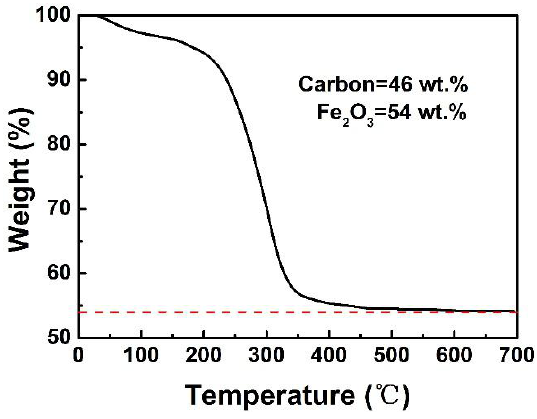
Figure 6. Thermogravimetric (TG) curve of the C@Fe 2 O 3